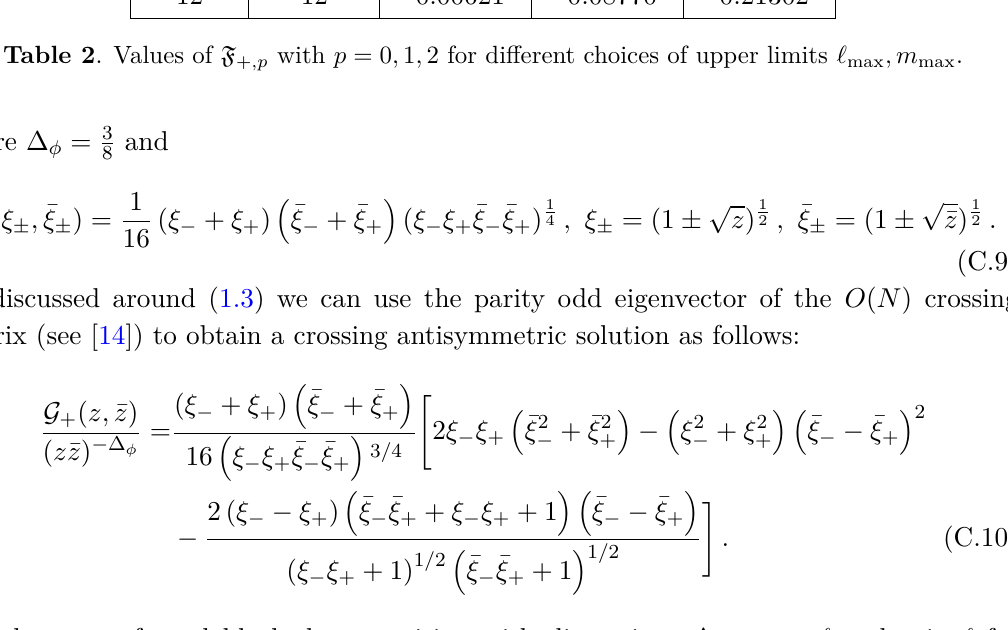
Table 2 . Values of F + ,p with p = 0 , 1 , 2 for different choices of upper limits ‘ max , m max .